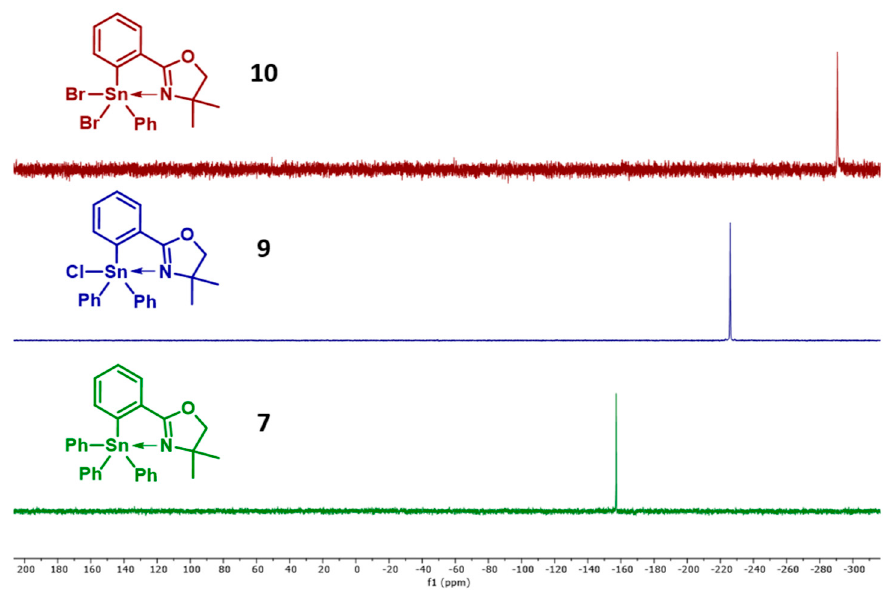
Figure 5. 119 Sn NMR spectra (CDCl 3 ) of 7 , 9 , and 10 .